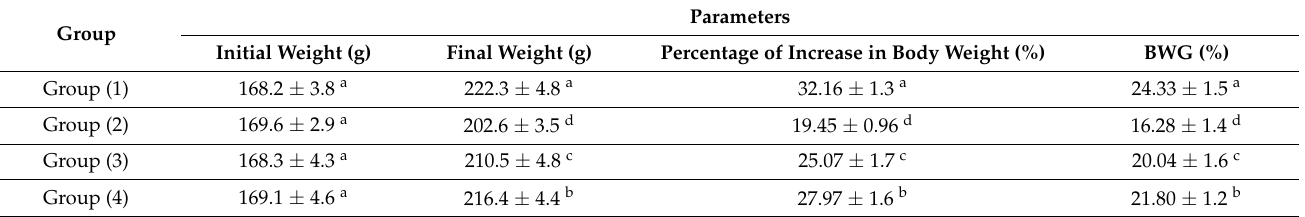
Table 4. Final weight and body weight gain of oxidative stress rats treated with fermented camel milk containing pumpkin seed